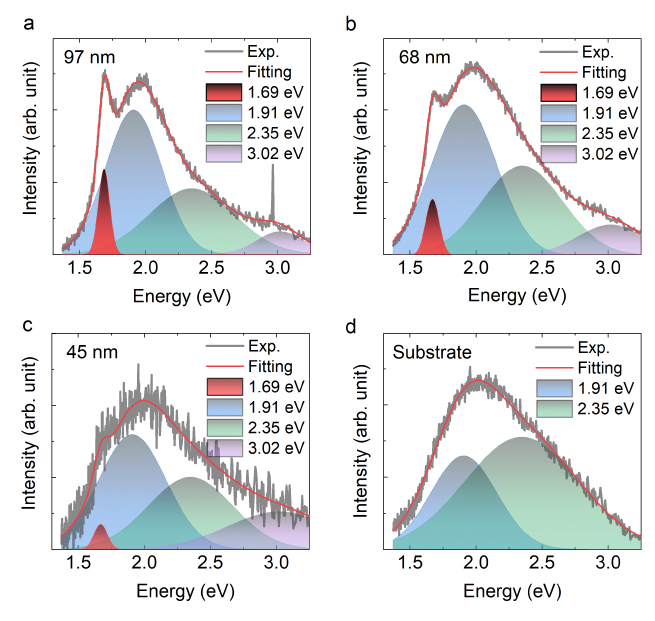
Figure 2. ( a – c ) Cathodoluminescence (CL) spectra of the GeS flakes with thickness of 97 nm, 68 nm, and 45 nm; all these spectra can be deconvoluted with four Gaussian components with centers at 1.69, 1.91, 2.35, and 3.02 eV. ( d ) The substrate CL spectrum can be fitted with only two Gaussian components centered at 1.91 and 2.35 eV.